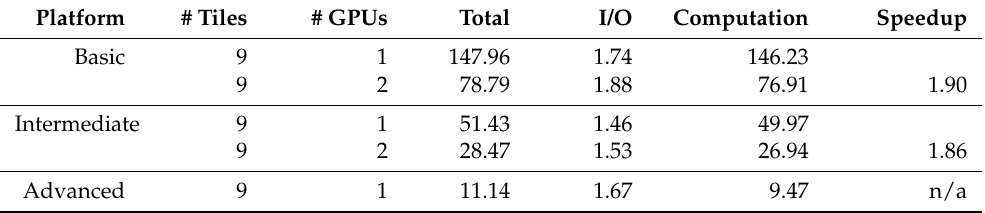
Table 10. Execution time (in minutes) for density estimation with adaptive bandwidths on the eBird sampling locations within and around Colorado ( n = 324,983 points; density raster cell size = 30